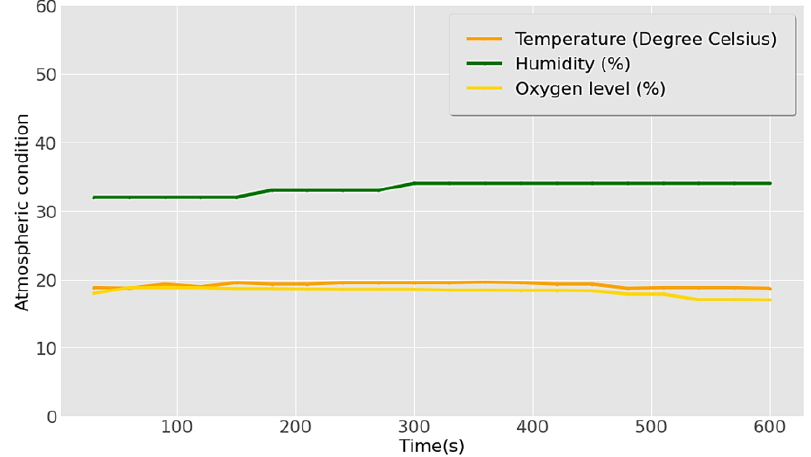
Figure 13. Results of atmospheric conditions in the wastewater treatment area.